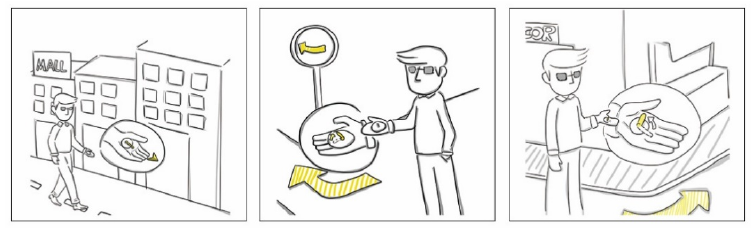
Figure 5. Typical application scenarios of guidance glove.